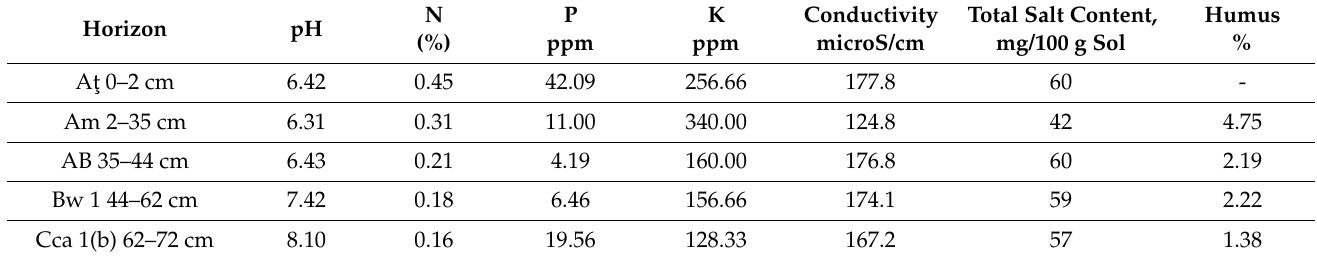
Table 4. Analytical data on the main agrochemical properties of the upstream profile of the standard plots, SCDCES—MM